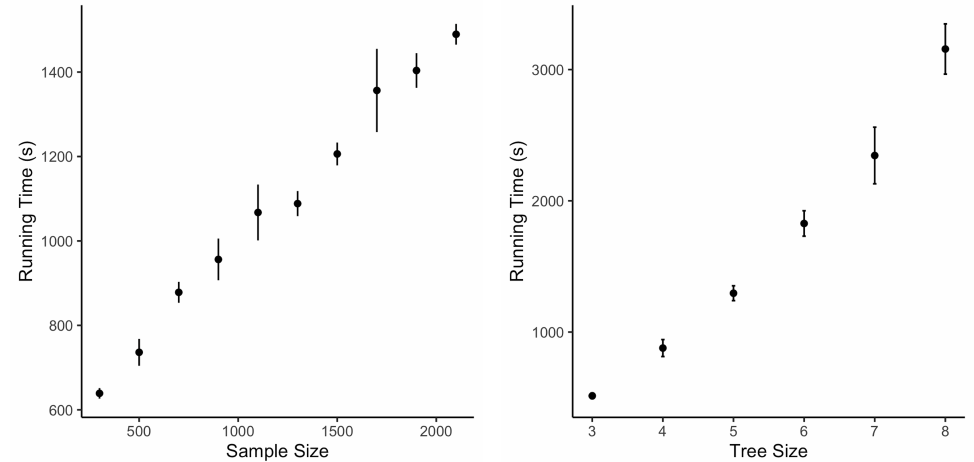
Figure 3. Running time with different sample sizes for tree